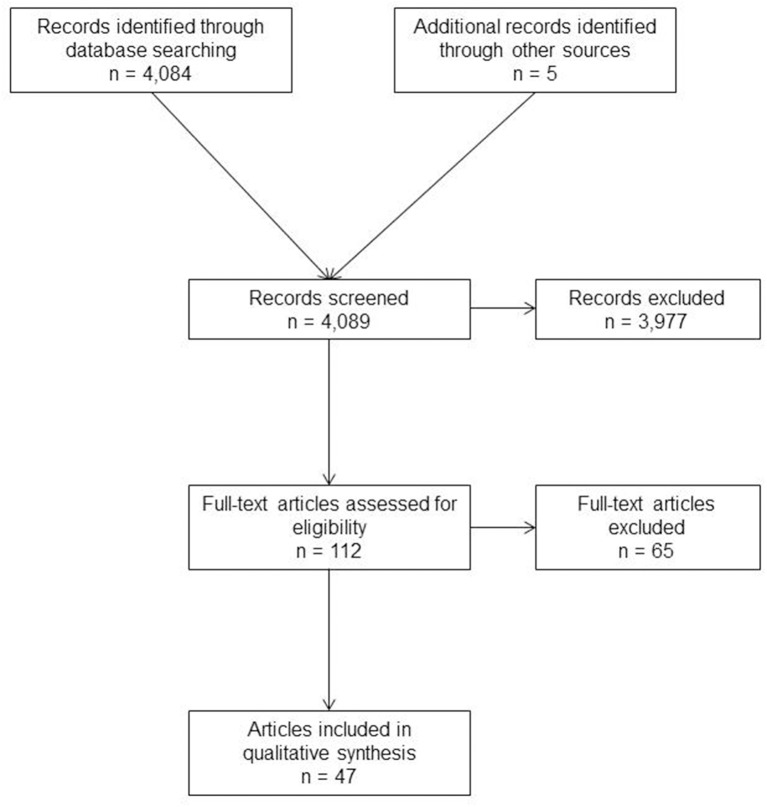
Prisma flow diagram of study inclusion.